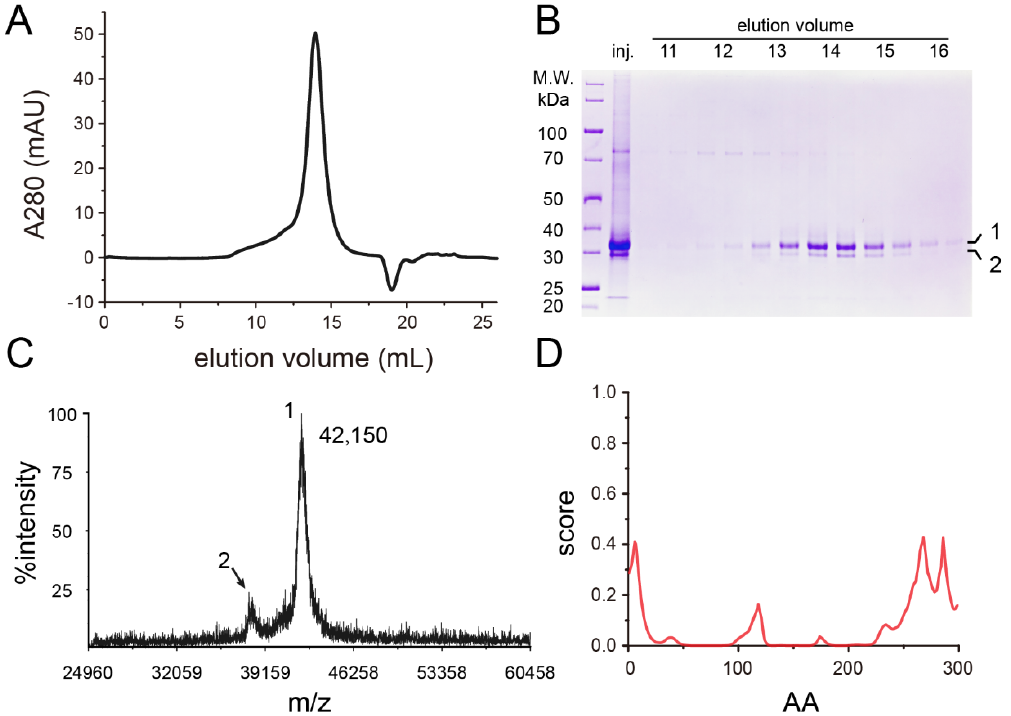
Figure 1. Purification and characterization of hDHHC3. ( A ) Representative size exclusion chromatography profile of full-length hDHHC3; ( B ) SDS-PAGE analysis of hDHHC3. Two bands are shown in the gel with the predicted size (band 1) and the degraded (band 2); ( C ) MALDI-TOF MS result of hDHHC3. The main peak (peak 1) shows that the molecular weight of the hDHHC3 protein is 42,150 Da, while the minor peak (peak 2) at ≈ 38 kDa represents the degraded hDHHC3; ( D ) The disordered regions of hDHHC3 were predicted using